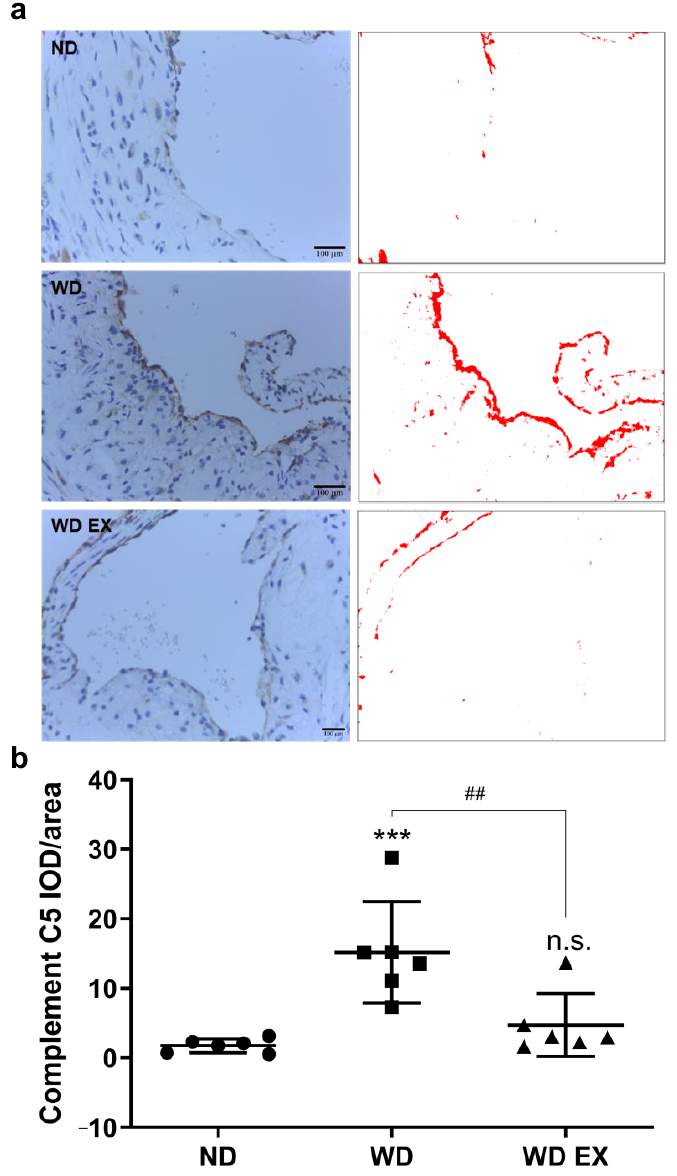
Figure 4. Effects of exercise on ( a ) aortic complement factor C5 expression and ( b ) quantitative analysis of the complement C5 IOD/area in ApoE knockout mice. Quantification of complement C5 staining and representative images. DAB-specific threshold selection (in red) from selected aortic root areas was performed using ImageJ, and total selective area was quantified and statistically analyzed. One-way ANOVA followed by Tukey’s post hoc test was used for statistical analysis, and *** p < 0.001 represents the significance between ND and WD groups. ## p < 0.01 represents the significance between WD and WD EX groups. n.s. = No significant difference.